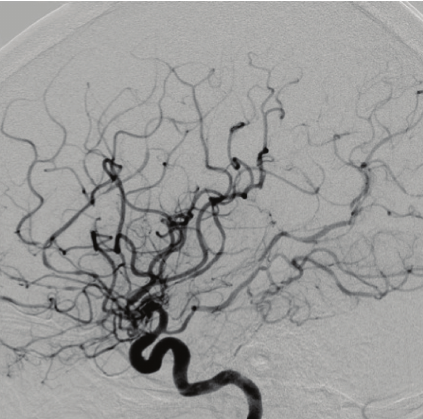
Figure 2: Digital subtraction angiography with injection of the right internal carotid artery showing narrowing of the arteries of both carotid and vertebrobasilar